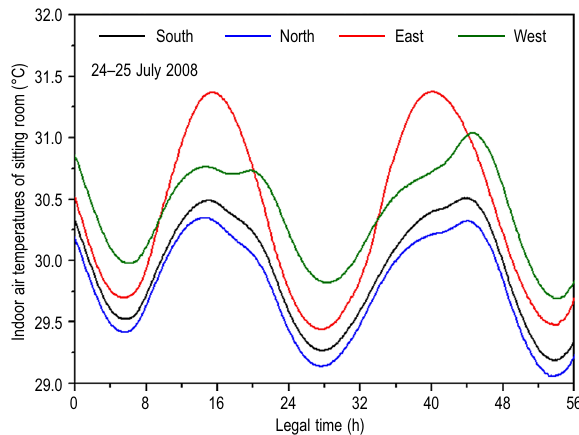
Fig. 12. Sitting room temperatures for an expansion parameter Agr = 3 in the case of stone, S/V ratio = 0.1977,